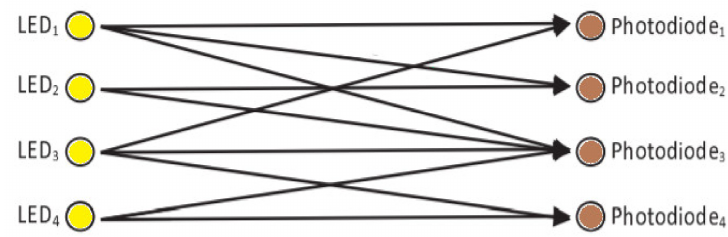
Figure 6. VLC channel MIMO